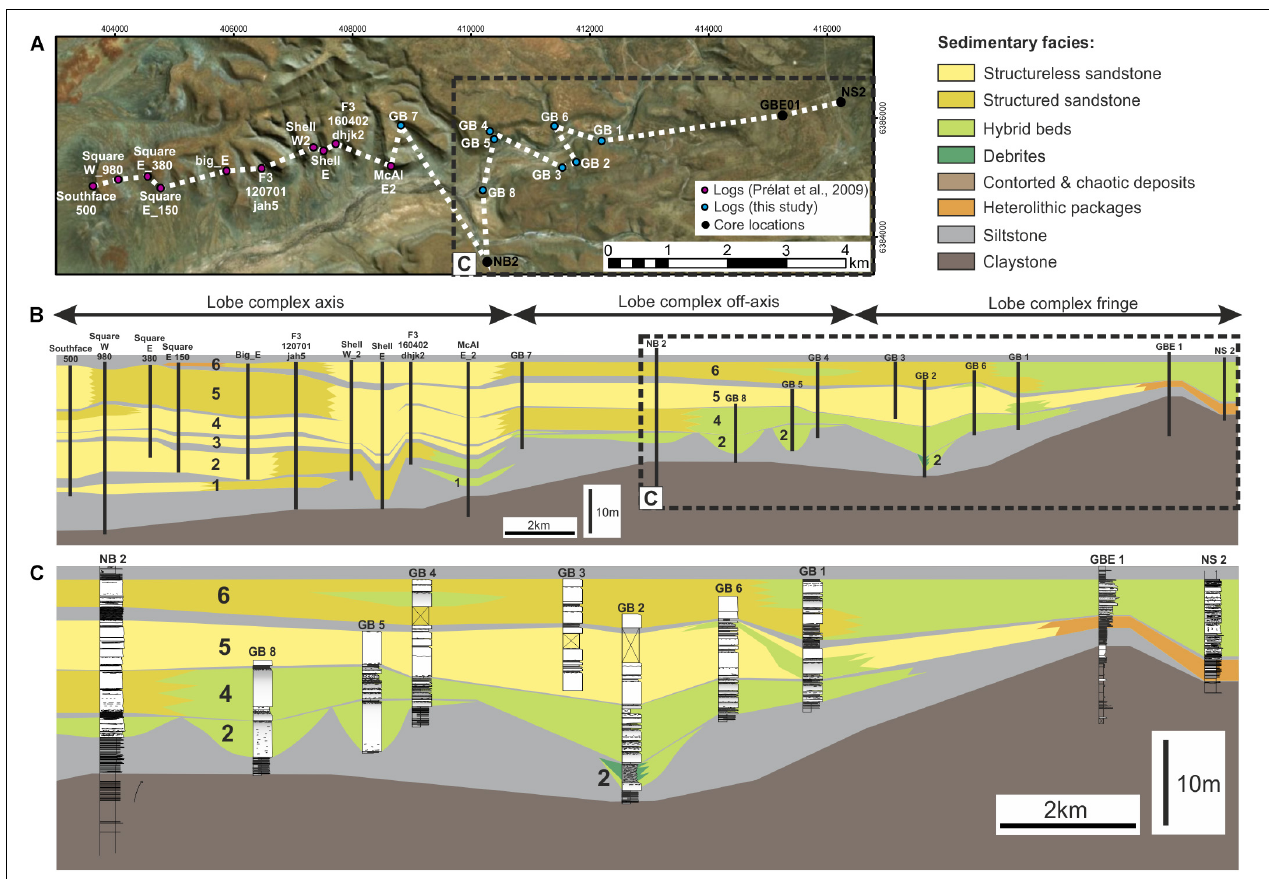
FIGURE 6 | (A) Map of Gemsbok valley showing the log and core locations included in this correlation. (B) Lateral pinchout correlation of Fan 3 in Gemsbok valley color coded by the dominant sedimentary facies at any one location. Note the amalgamation of lobes 4 and 5 in the lobe complex axis. (C) Zoom in of the easternmost part of the lateral pinchout of Fan